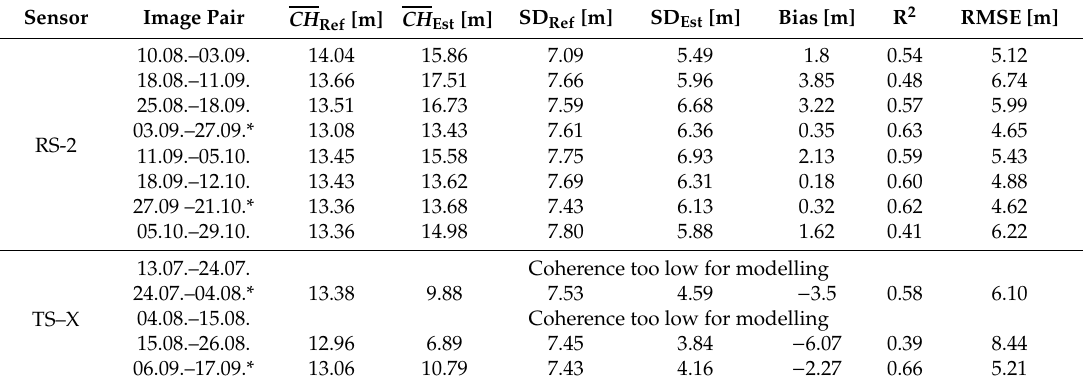
Table 3. Validation statistics of canopy heights per interferogram based on LiDAR data. ( CH Ref = mean of the reference canopy height, CH Est = mean of the estimated canopy height, SD = standard deviation, RMSE = root mean square error).